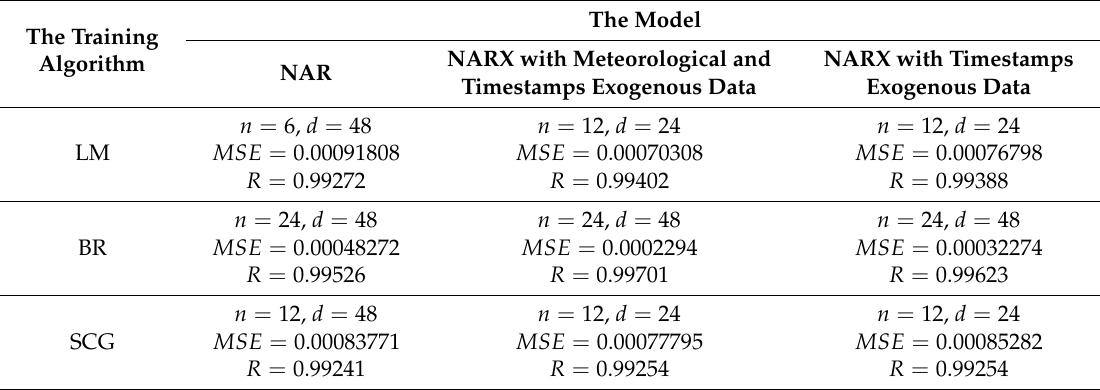
Table 6. The optimum mix ( n , d ) and the corresponding performance metrics.